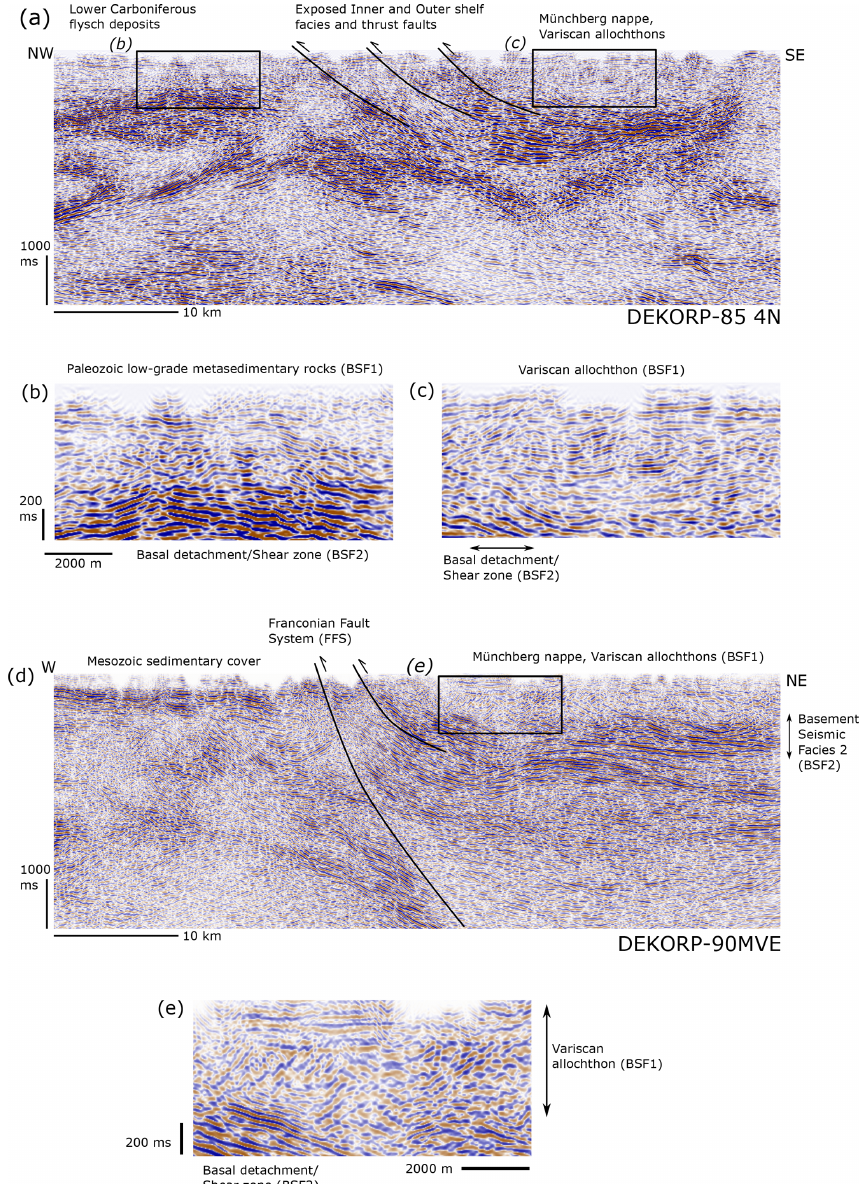
Figure 5. Reprocessed DEKORP-85 4N and DEKORP-3/MVE-90 profiles used to compare three basement seismic facies (BSF1-3) de- scribed along the FRANKEN seismic survey (see Fig. 1 for locations). DEKORP profiles image exposed Variscan units along the western Bohemian Massif and are used as proxy for geological interpretation of BSFs. (a) DEKORP-85 4N shows the seismic signature of Paleozoic low-grade metasedimentary rocks (zoomed in b ) and Münchberg Nappe (Variscan allochthon, zoomed in c ) exposed at the surface and de- scribed as BSF1. (d) DEKORP-3/MVE-90 images of Münchberg Nappe units to the east and Permian–Jurassic sedimentary cover to the west of Franconian Fault System (FFS). Panel (e) shows the seismic signature of Variscan nappes (BSF1) and underlying shear zones (BSF2).